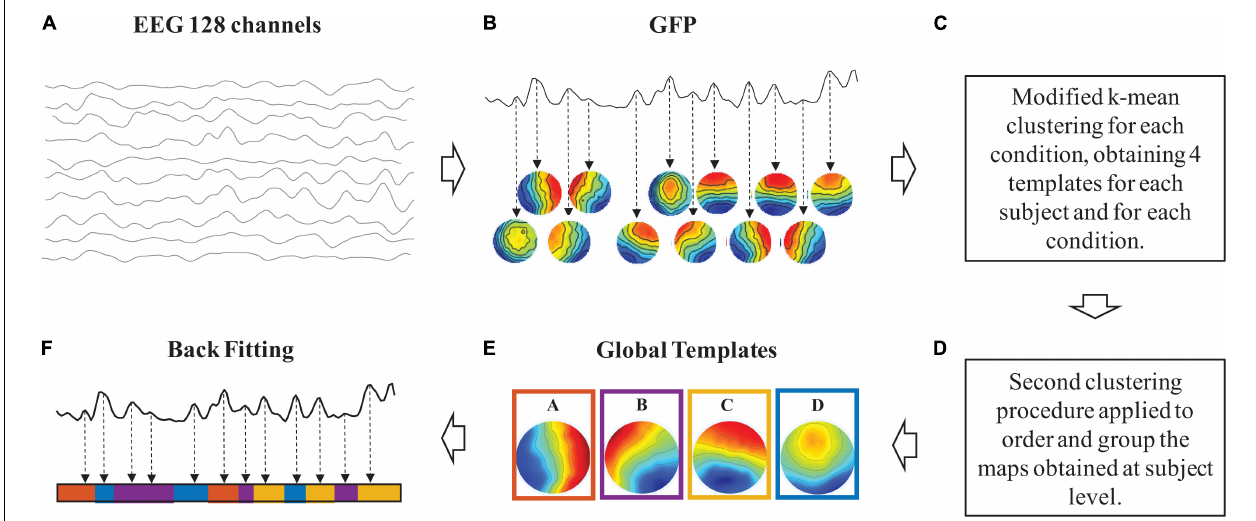
FIGURE 1 | Schematic representation of the sequence of steps taken for the microstate analysis. In clockwise order: samples of 1 s of noise-free EEG signals (A). Intervals of stable topographical configurations (B) . Identification of the number of dominant microstate templates (C). Clustering procedure for the definition of the global microstate templates (D) . Identified global templates (E) . Backfitting of the global microstate templates to the noise-free EEG signals (F)